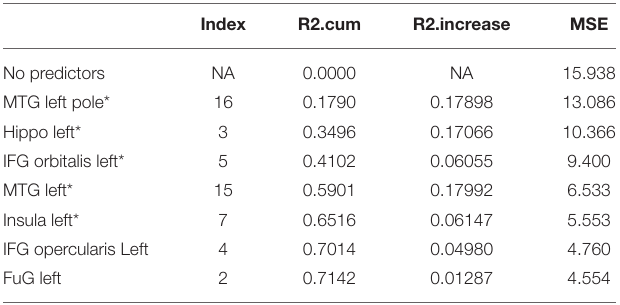
TABLE 8 | Results from a stepwise regression with the brain areas as predictors and Delayed Recall (Trial) as the dependent variable.